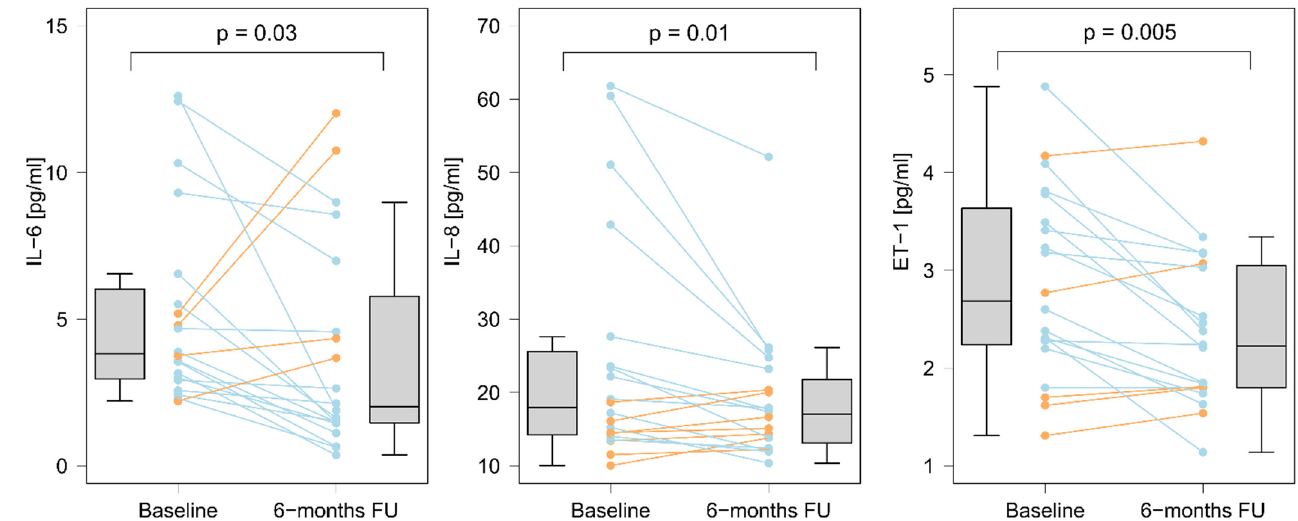
Figure 2. Serum concentrations of biomarkers before and after completion of BPA treatment. There was a decrease in concentrations of IL-6 ( ∆ = − 1.61 ( − 3.11; − 0.20); p = 0.03), of IL8 ( ∆ = − 3.24 ( − 7.72; 0.82); p = 0.01), and of ET-1 ( ∆ = − 0.47 ( − 0.96; 0.05); p = 0.005). The orange color indicates an increase, and the blue color indicates a decrease. The difference between the two time points was determined using the Wilcoxon matched-pairs signed-rank test.